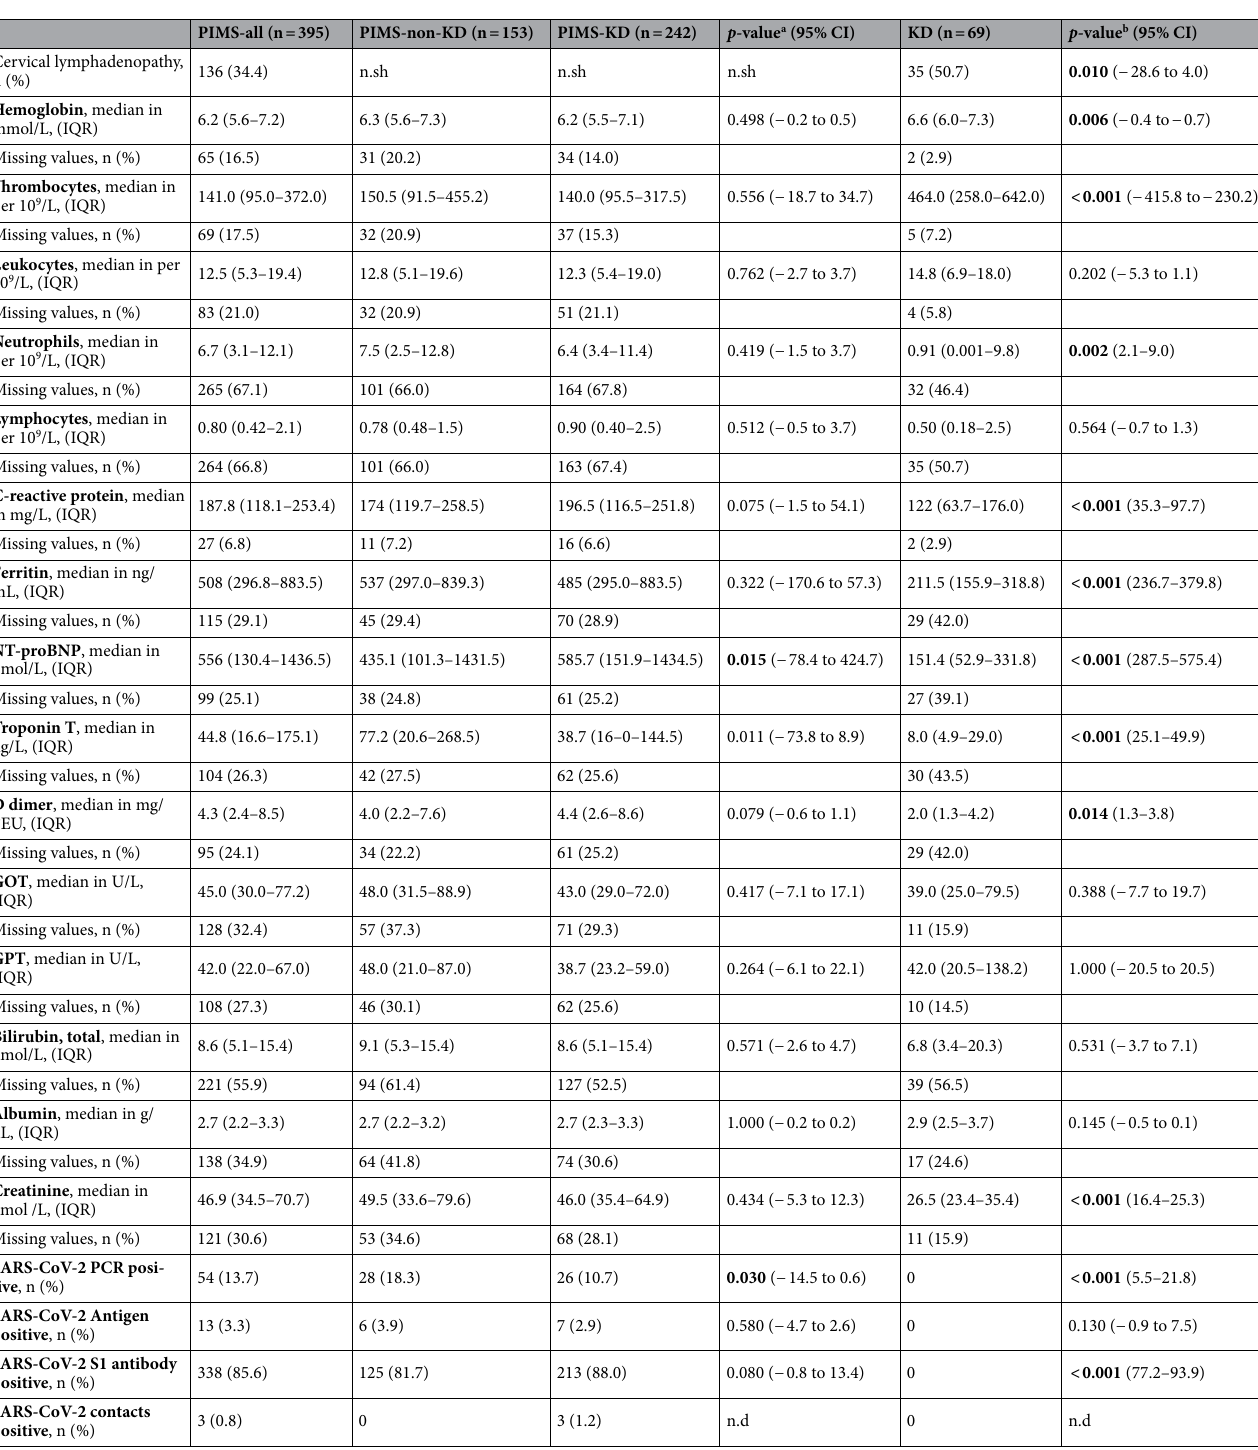
Table 2. Clinical symptoms and significant laboratory values in patients with PIMS-all, PIMS-non-KD, PIMS-KD and KD. PIMS, pediatric multisystem inflammatory syndrome; KD, Kawasaki disease. a comparison between PIMS-non-KD and PIMS-KD. b comparison between PIMS-all and KD; 95% CI, 95%-confidence interval; n; number of cases; n.sh., not shown due to expected differences in case definitions; pARDS, pediatric acute respiratory distress syndrome; IQR, interquartile range; PCR, polymerase chain reaction; n.d.; not determined. P values in bold are considered statistically